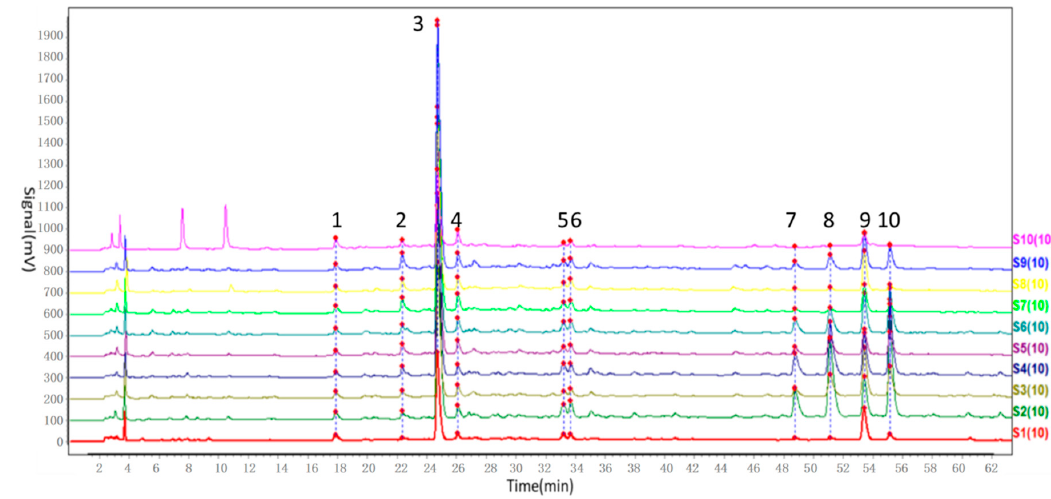
Figure 1. Fingerprint of ZZX. 1 : Neochlorogenic acid, 2 : Unknown compound X, 3 : Chlorogenic acid,